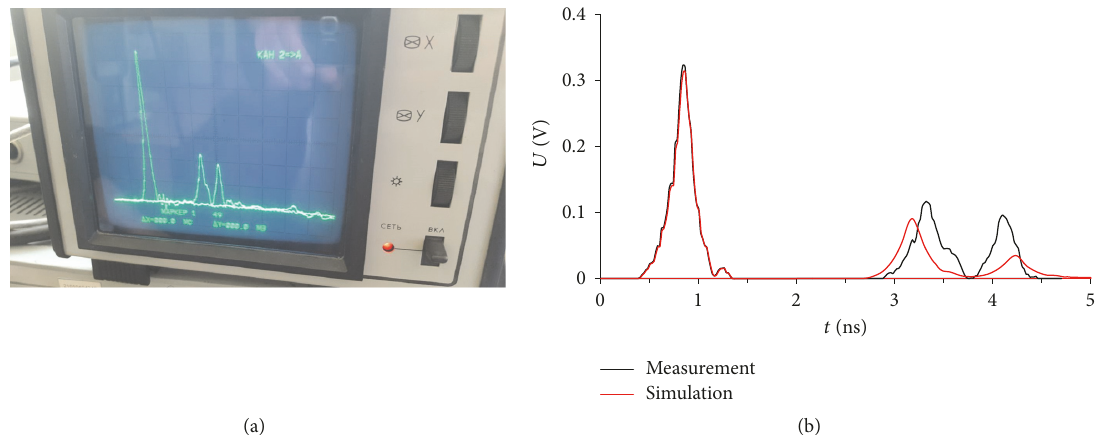
Figure 5: Photography of the oscilloscope S9–11 with measured input and output voltage waveforms (a); comparison of measured and simulated voltage waveforms (b) for the experimental PCB.